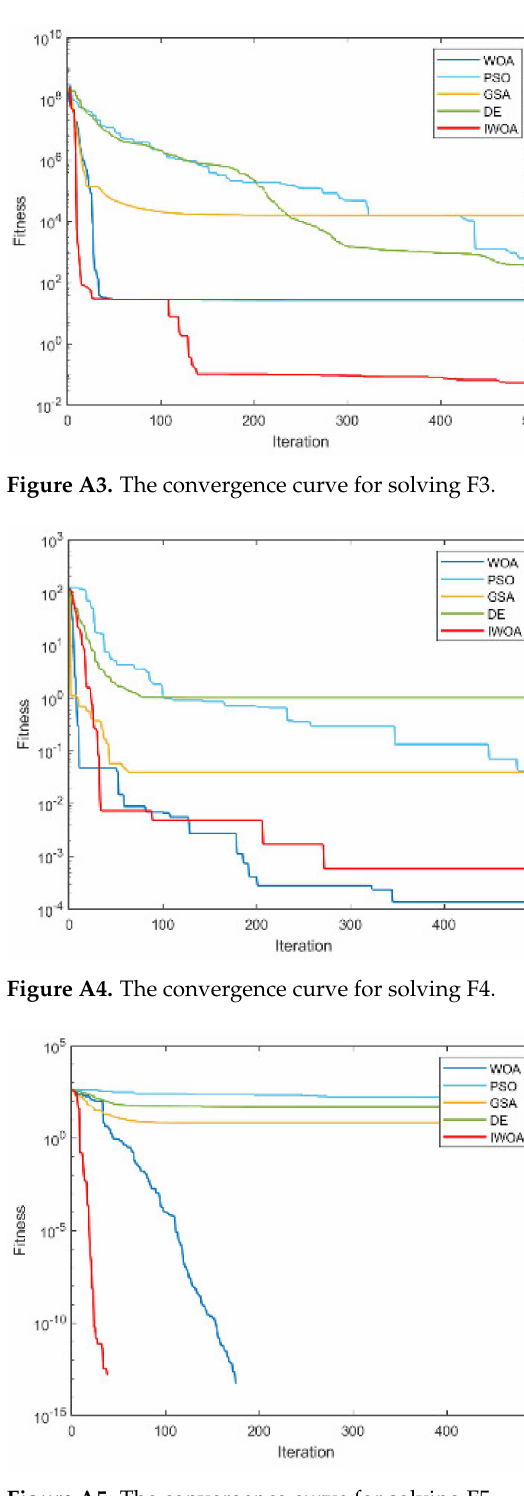
Figure A5. The convergence curve for solving